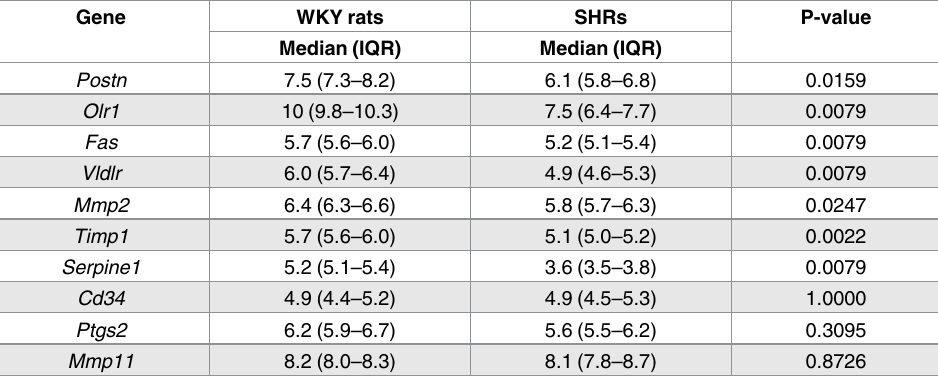
Table 2. Expression levels of genes verified by